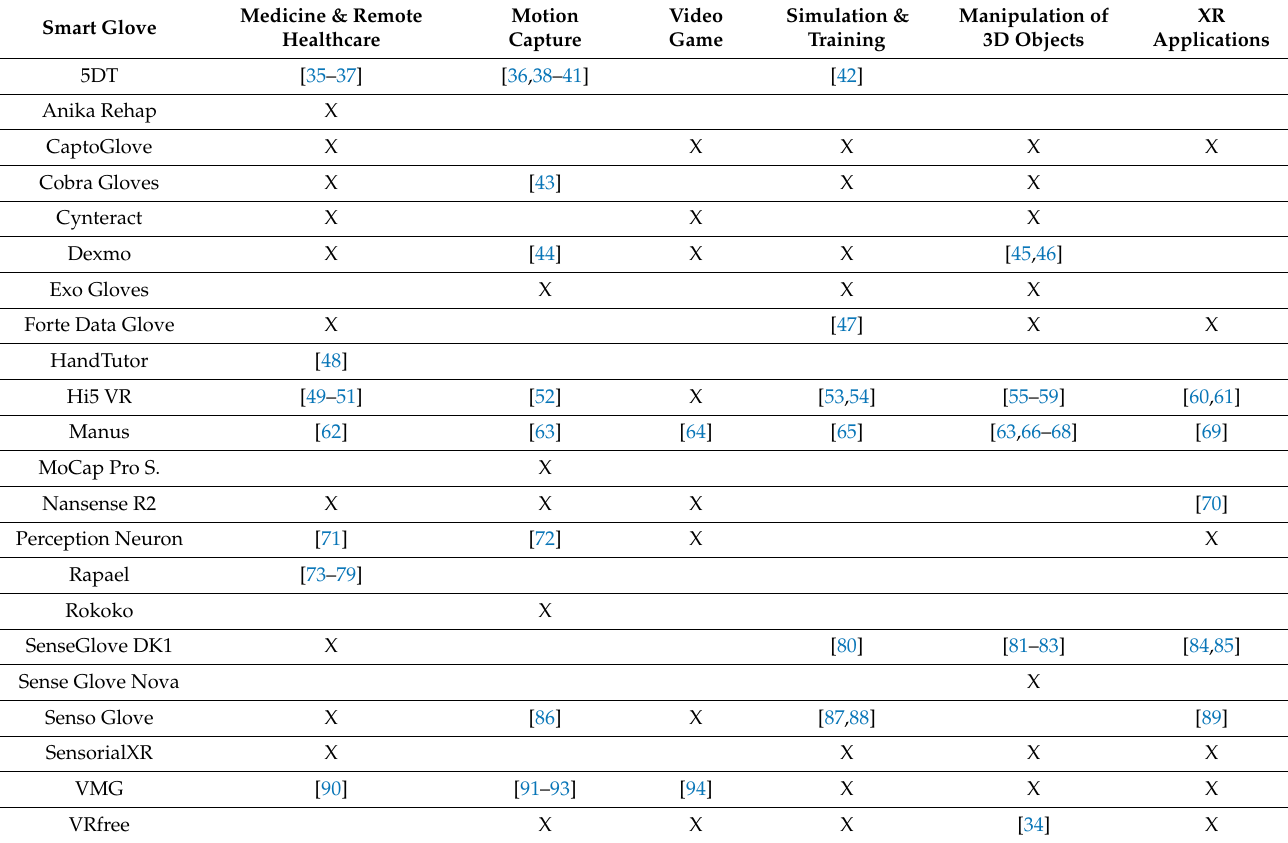
Table 8. Commercial smart gloves by application